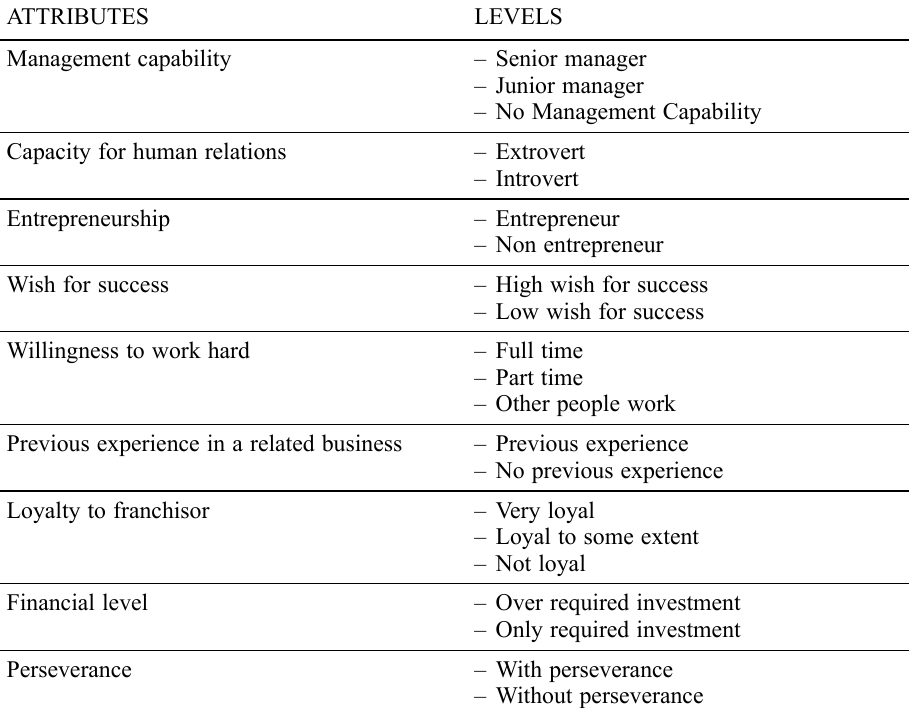
Table 3. Identification of attributes and establishment of